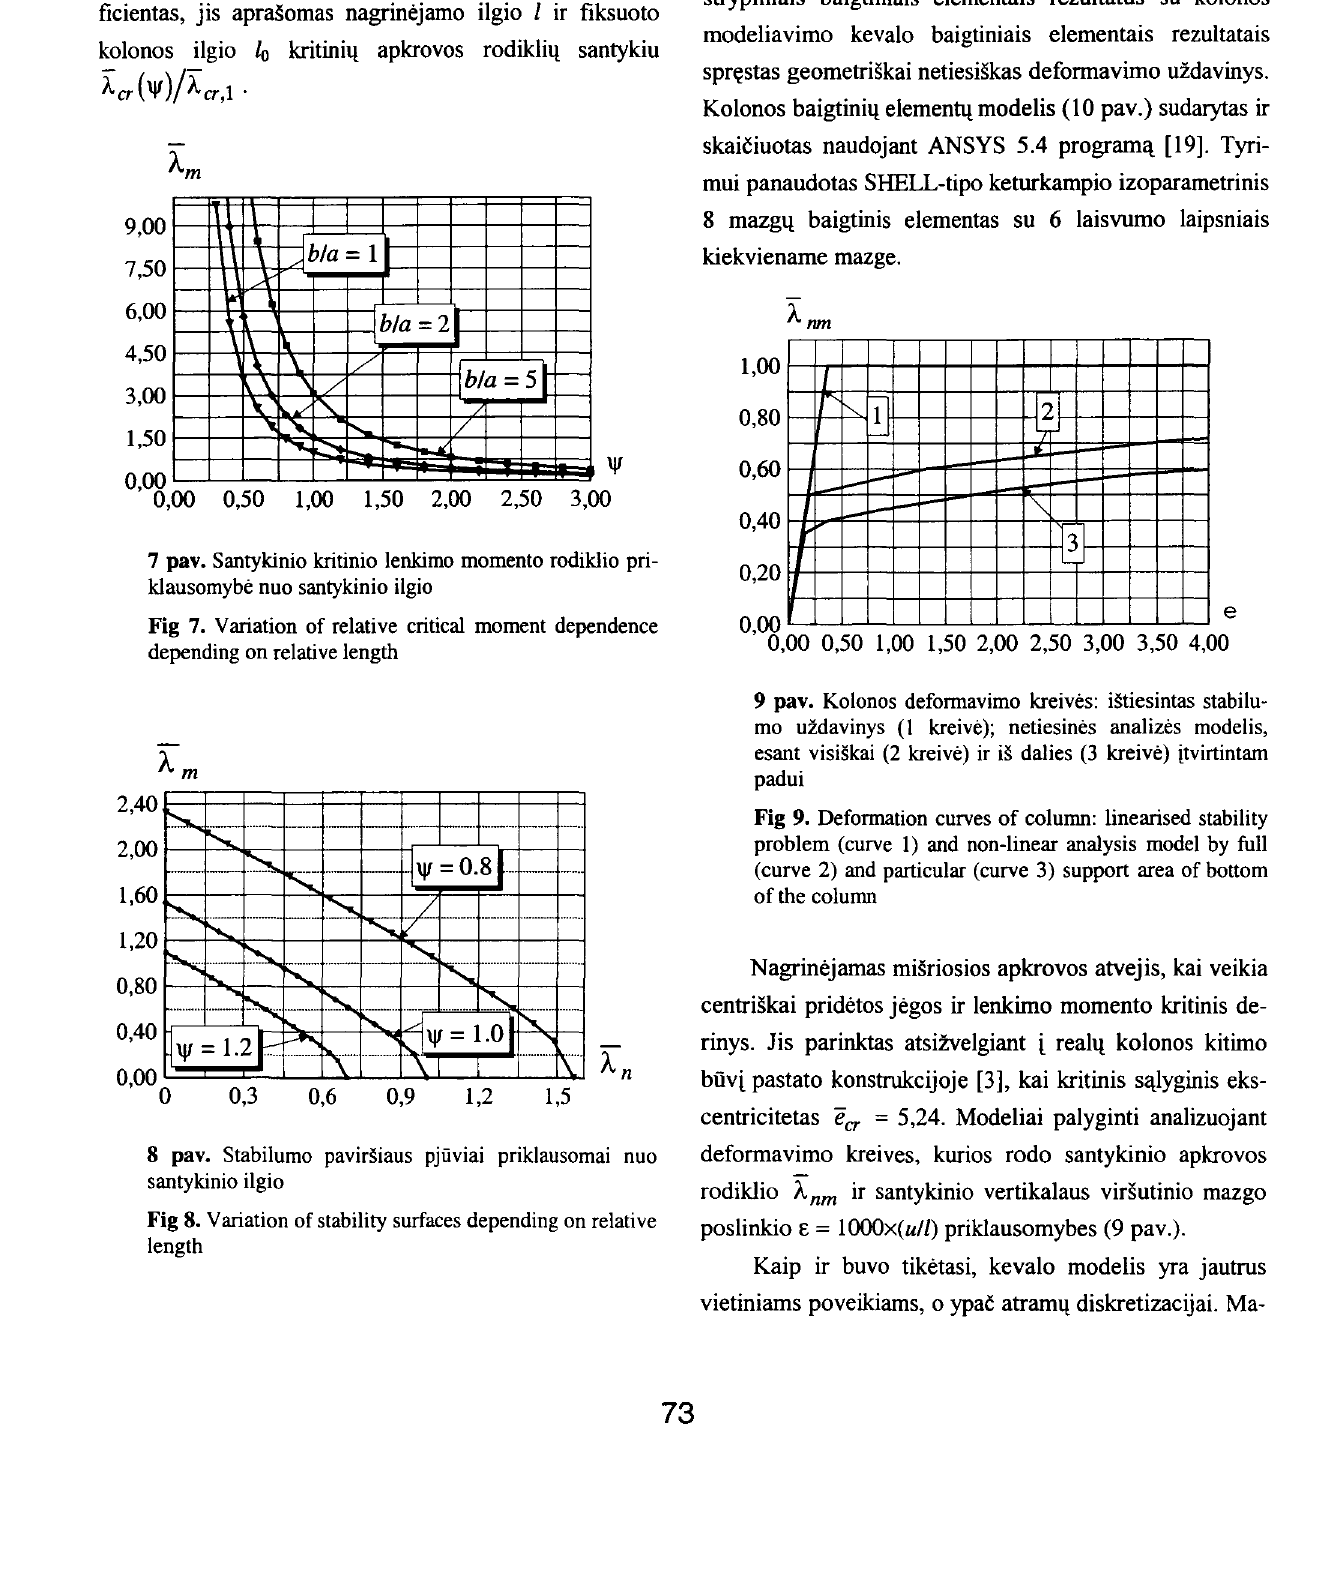
Fig 7. Variation of relative critical moment dependence depending on relative length